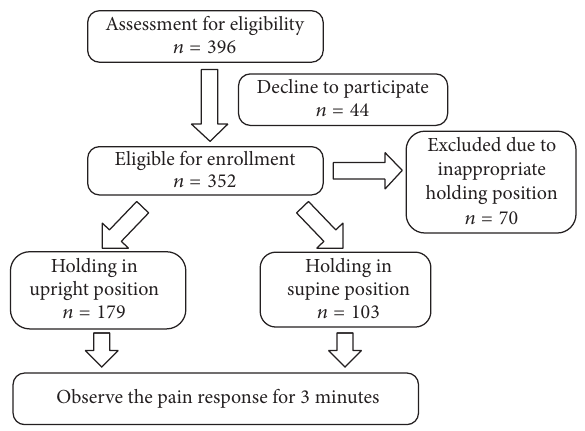
Figure 1: Schematic of study interventions and